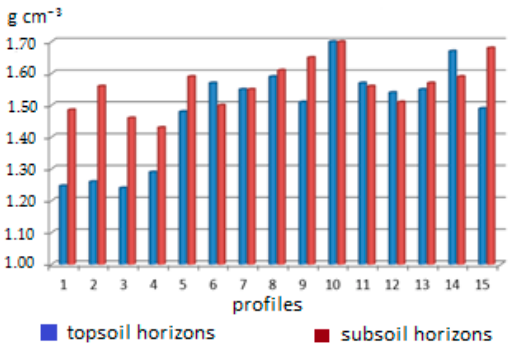
Figure 5. Bulk density of the soil profiles.